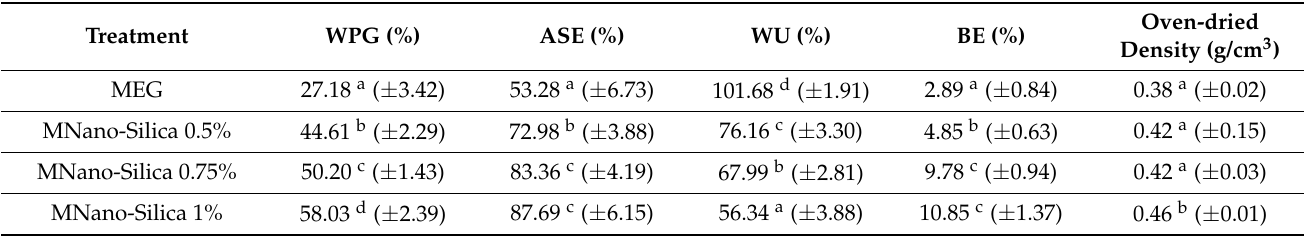
Table 2. Testing the dimensional stability of sengon wood.